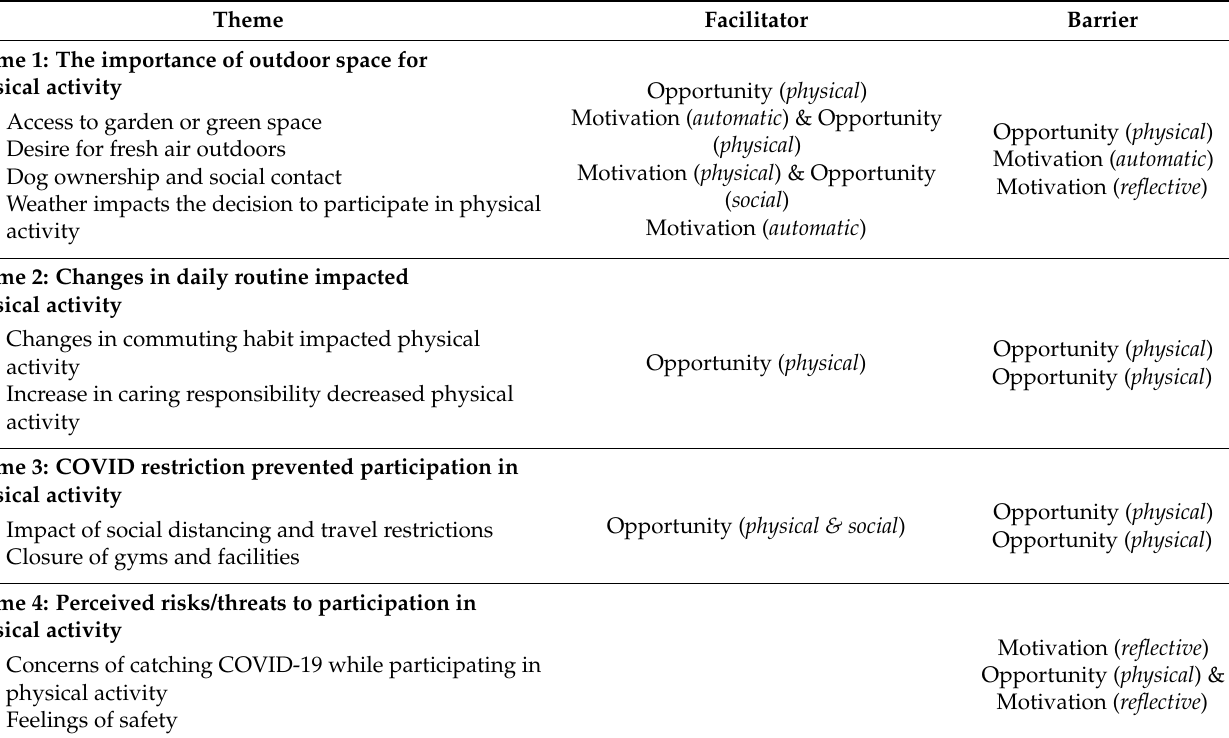
Table 4. Themes mapped onto COM-B